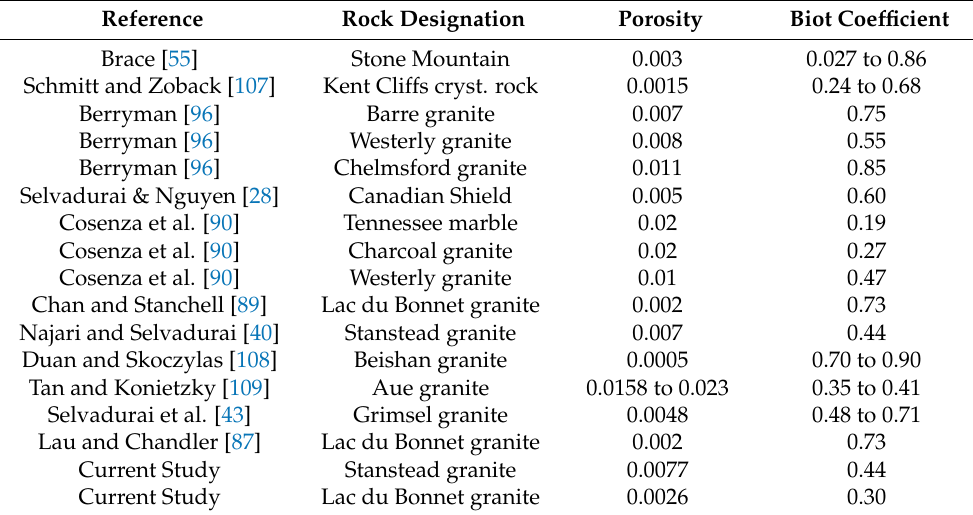
Table 5. Biot coefficients for low permeability rocks such as granite and